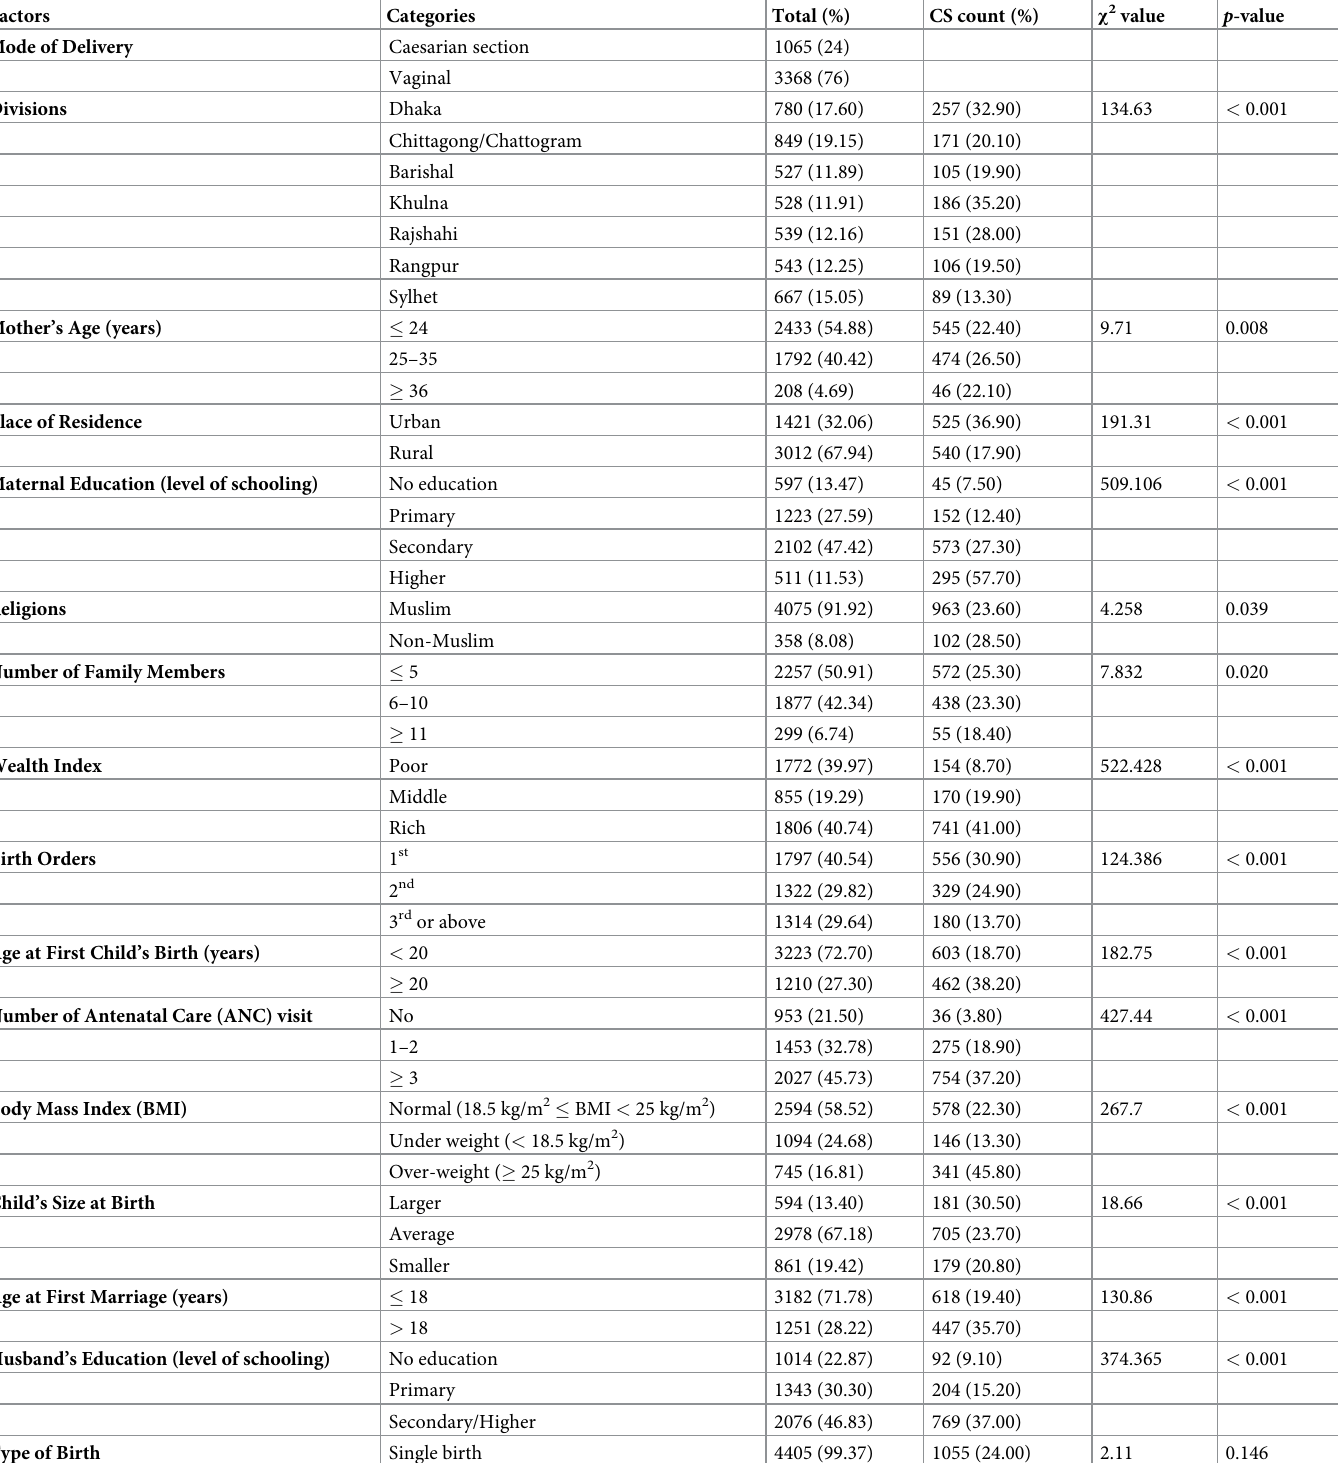
Table 1. Association of the mode of delivery with socioeconomic and demographic factors for the ever-married women of reproductive age in Bangladesh (N =